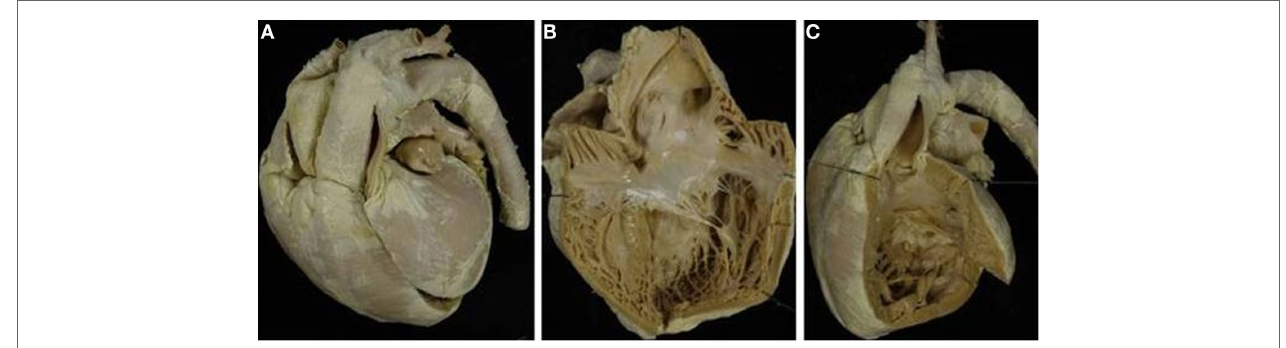
FigUre 11 | corrected Tga with intact septum in situs solitus . (a) External view of the heart with the aorta in left anterior position. (B) The morphologically right atrium, characterized by the presence of the crista terminalis, connects with the morphologically left ventricle (discordant AV connection). (c) The aorta takes origin from the left-sided morphological right ventricle (discordant VA